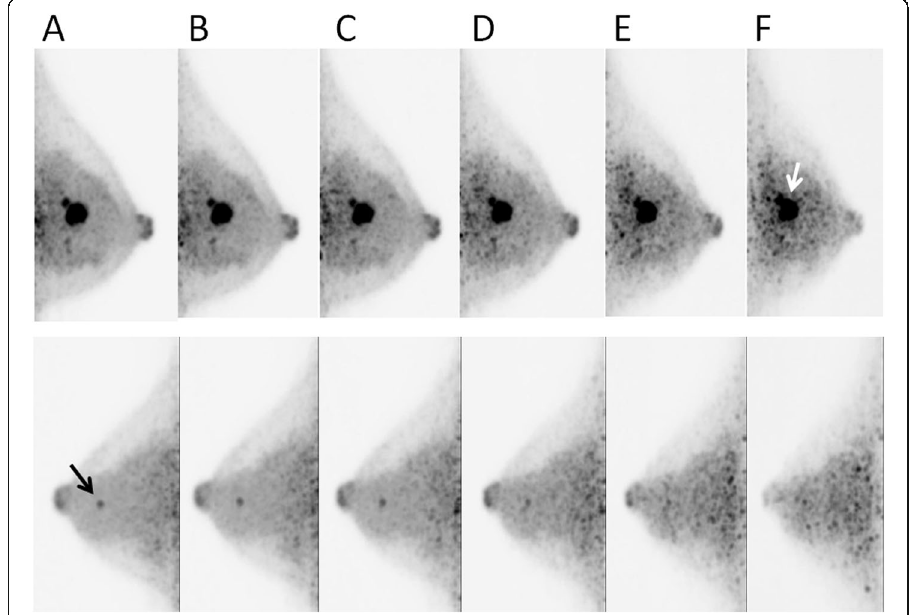
Fig. 5 A representative case involving a 44-year-old patient with bilateral breast cancers: a 100% (acquisition time was 420 s), b 75% dose (acquisition time was 315 s), c 50% dose (acquisition time was 210 s), d 25% dose (acquisition time was 105 s), e 12.5% dose (acquisition time was 52 s), and f 6.25% dose (acquisition time was 26 s) of the simulated 18 F-FDG dose. The left-sided breast cancer of 13 mm in diameter (white arrow) was confirmed with 6.25% dose as well as that for 100% dose (upper row). The right-sided breast cancer of 6 mm in diameter (black arrow) was unclear and difficult to distinguish from noise at the 12.5% dose or lower. Abbreviation: 18 F-FDG, fluorine-18-labeled